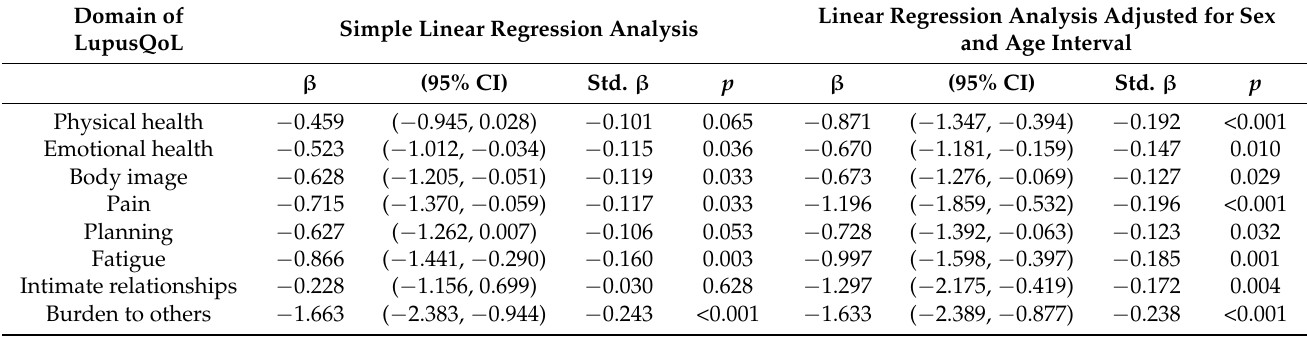
Table 3. Linear regression analyses of the eight domains of Lupus Quality of Life (LupusQoL) with the Systemic Lupus Erythematosus Disease Activity Index 2000 (SLEDAI-2K) in patients with systemic lupus erythematosus. Domain of Linear Regression Analysis Adjusted for Simple Linear Regression Analysis LupusQoL